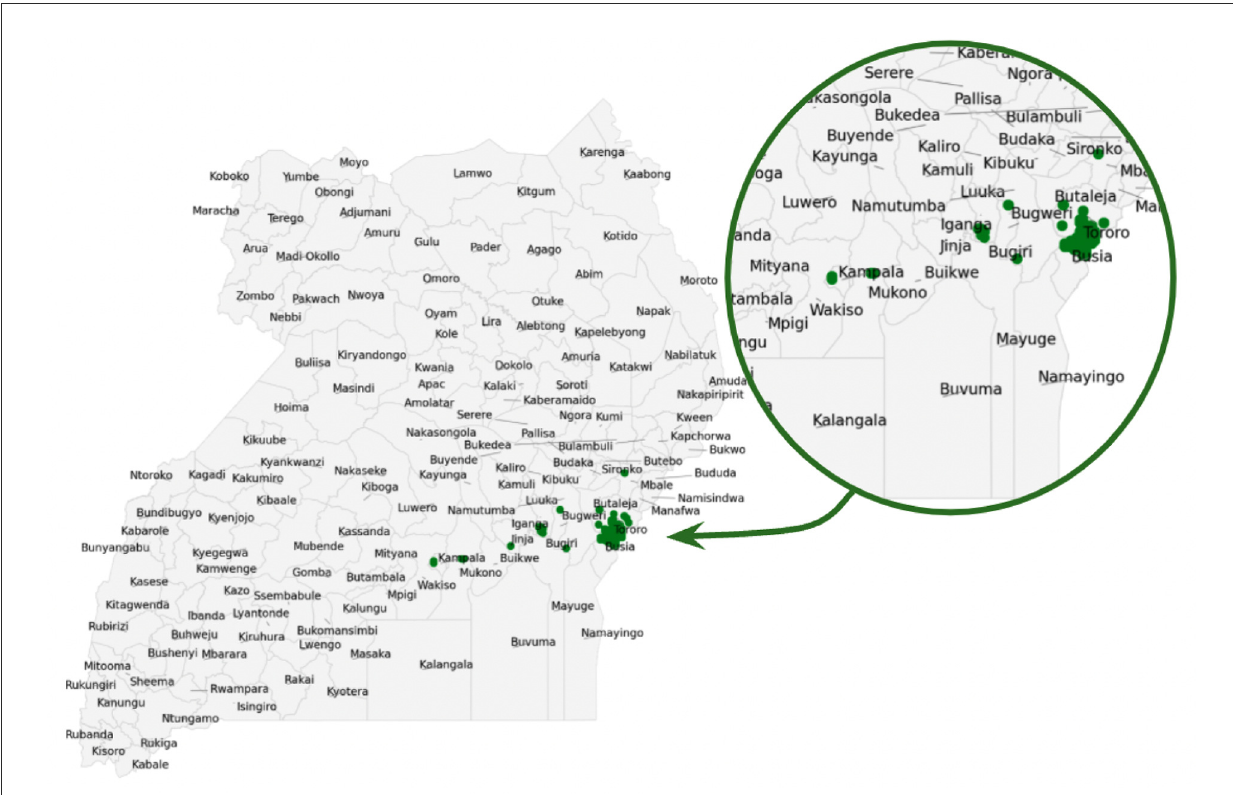
FIGURE1 Data collection in eastern Uganda. Zoom-in highlights the districts represented by green spots. Green spots indicate the regions that participated in the data collection.